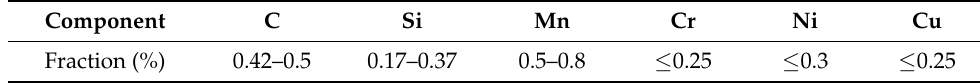
Table 1. Chemical composition of 1045 steel.